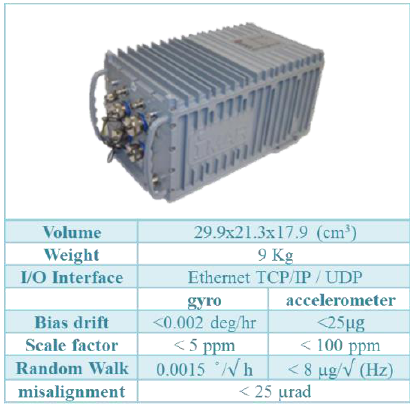
Figure 6: The proposed MMS cart